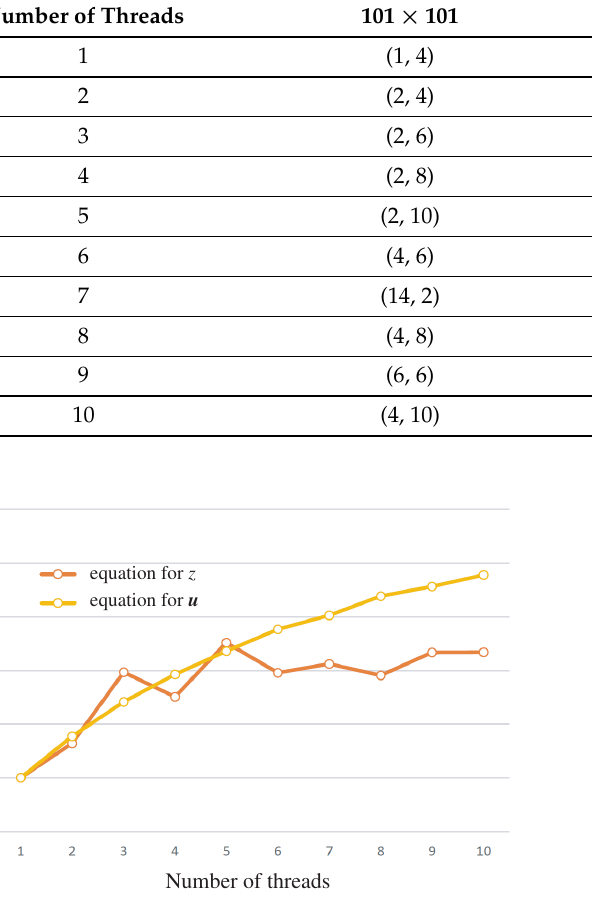
Figure 6. Parallel acceleration for the 101 × 101 mesh.